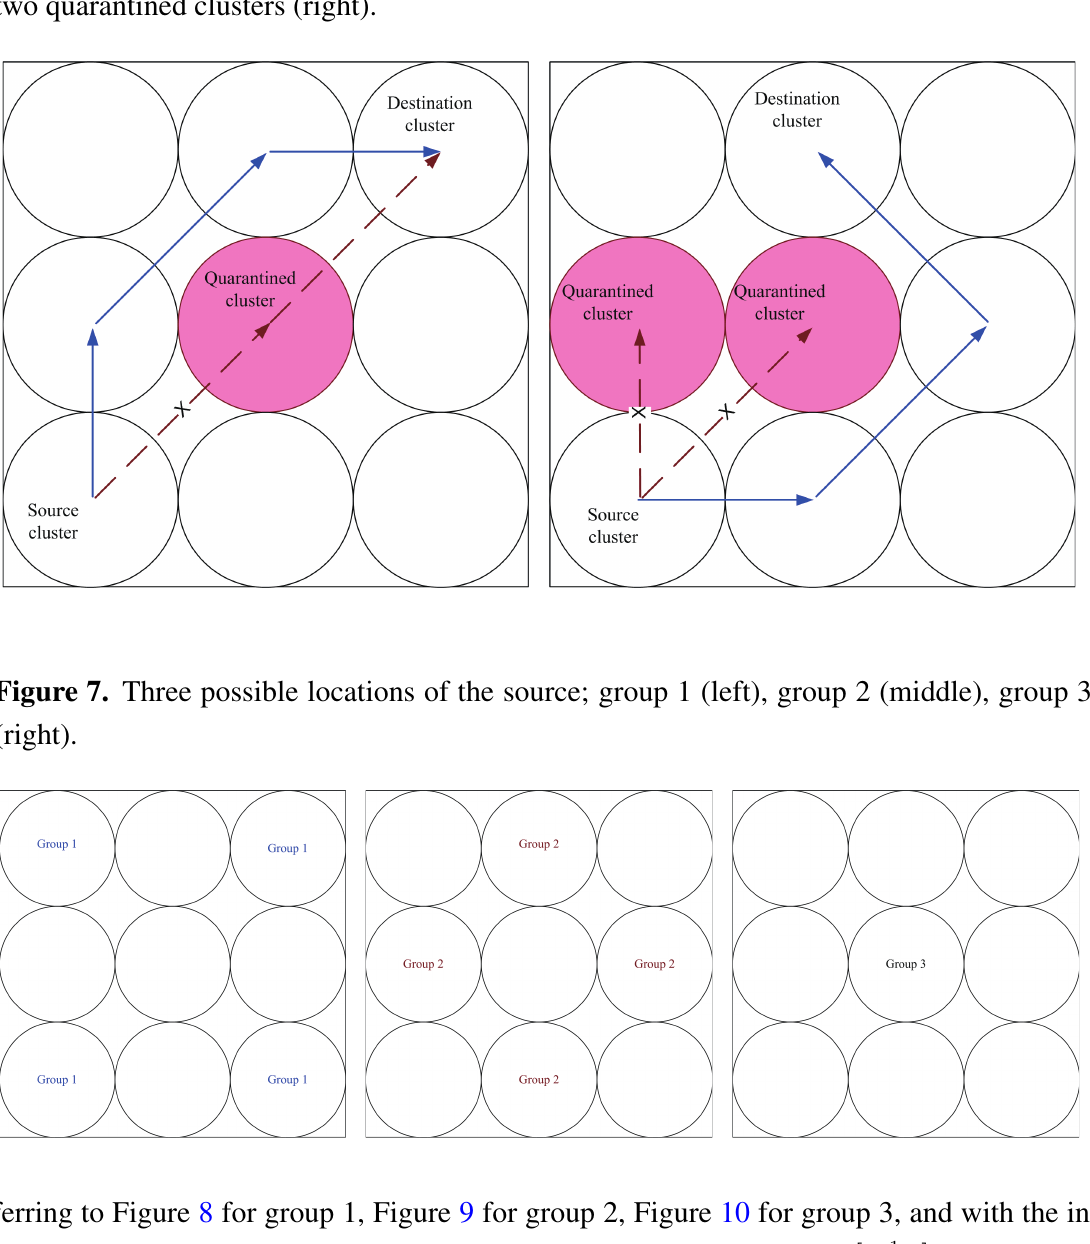
Figure 6. The path interference of the quarantined cluster; one quarantined cluster (left), two quarantined clusters (right).